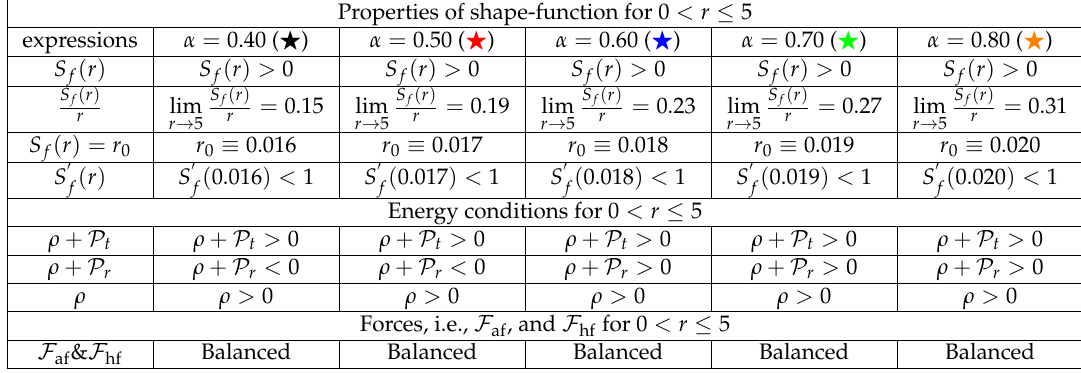
Figure 4. The variational development of ρ and balancing behavior of F af , and F hf . Here, α = 0.40 ( (cid:70) ), α = 0.50 ( (cid:70) ), α = 0.60 ( (cid:70) ), α = 0.70 ( (cid:70) ), α = 0.80 ( (cid:70) ), and γ = 0.10. Table 1. Summary of the